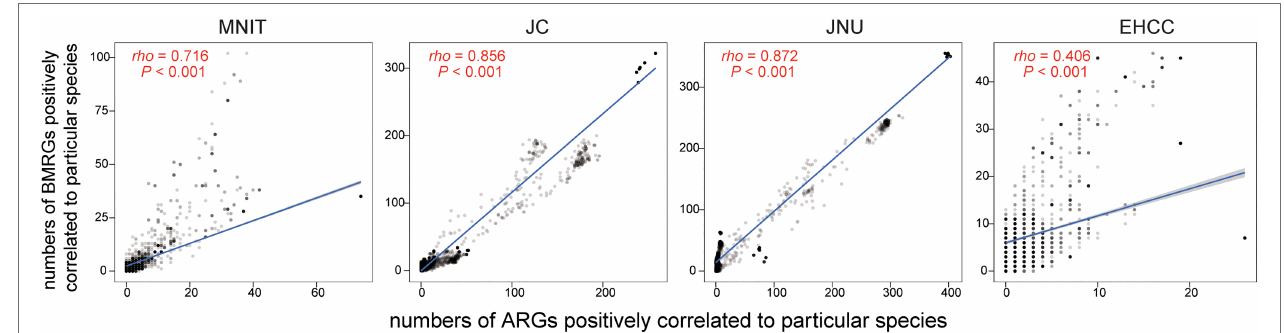
FIGURE 5 | The correlation between the number of ARGs and the number of BMRGs, in which ARGs and BMRGs are positively correlated to one species with Spearman’s correlation coefficient > 0.6. Each dot corresponds to one bacterial species that is regarded as the host of ARGs and BMRGs. Spearman’s correlation coefficient between them and p value are shown in